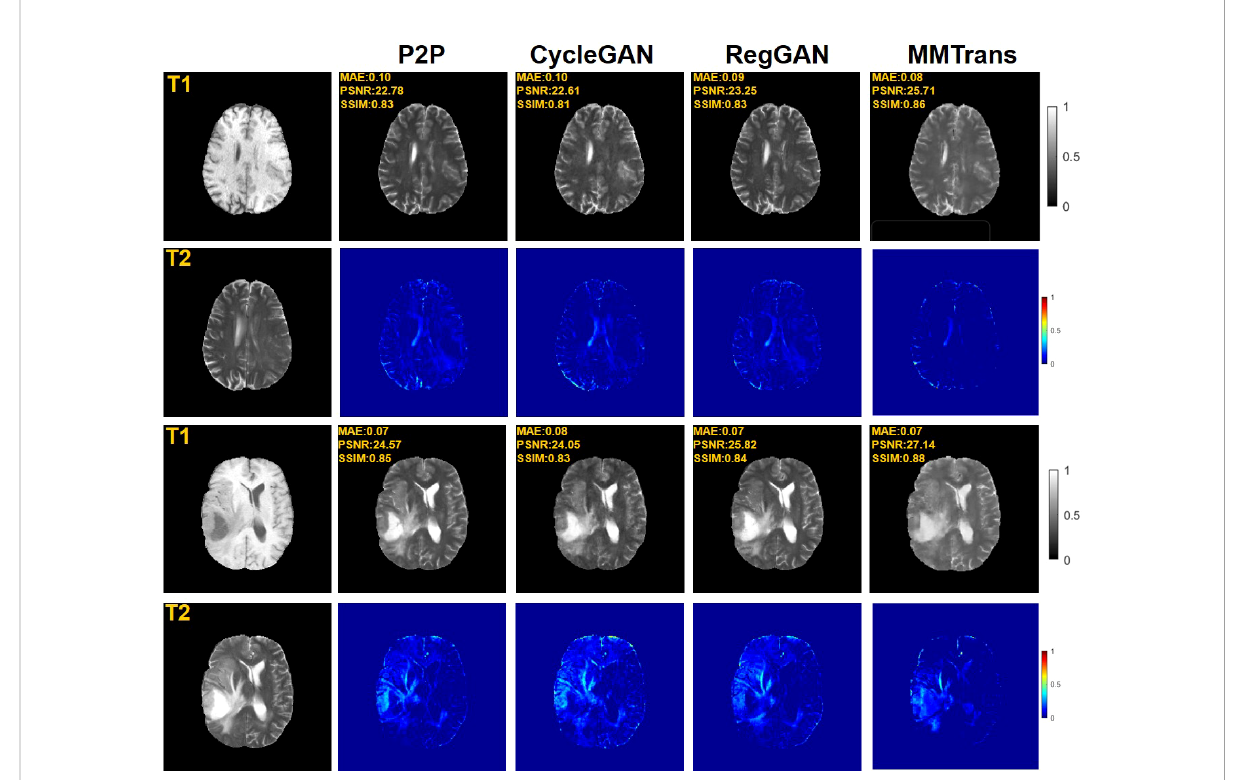
FIGURE 3 Qualitative results of T1 modality translation to T2 modality using the BraTs2018 paired dataset with different translation methods, displaying translation images and corresponding error